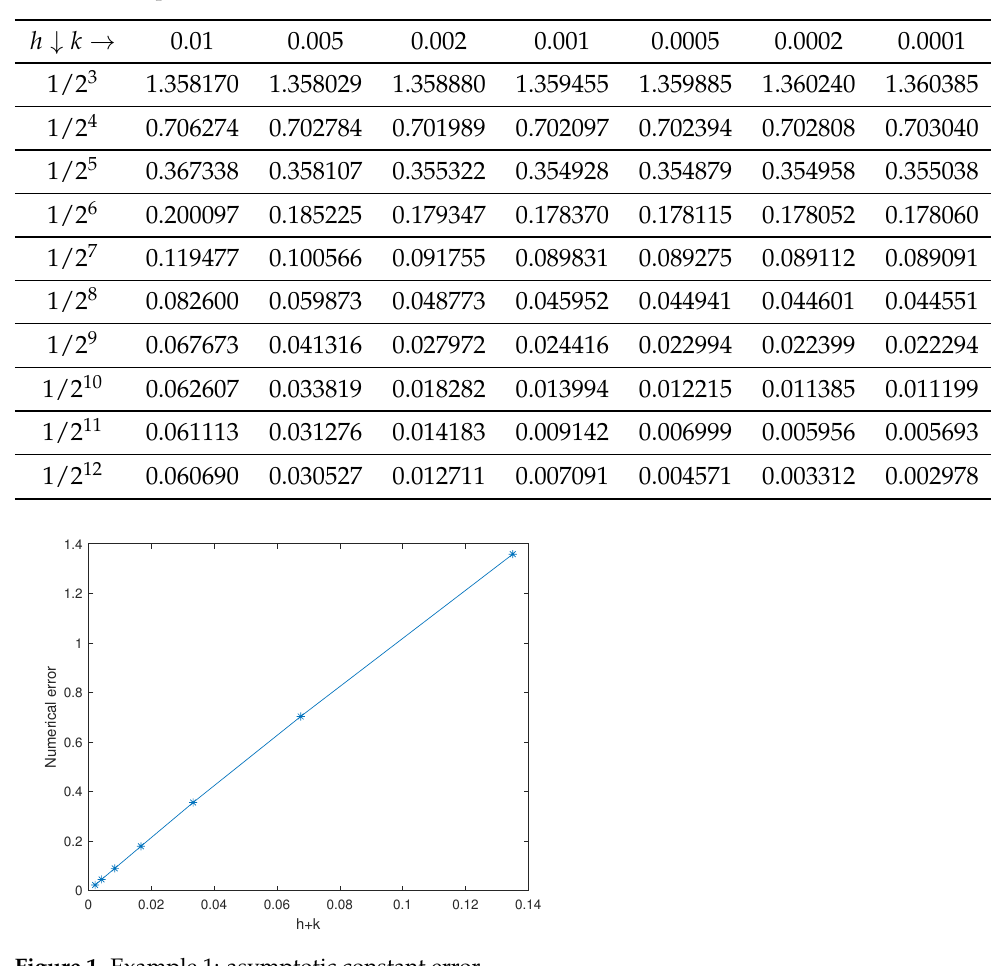
Figure 1. Example 1: asymptotic constant